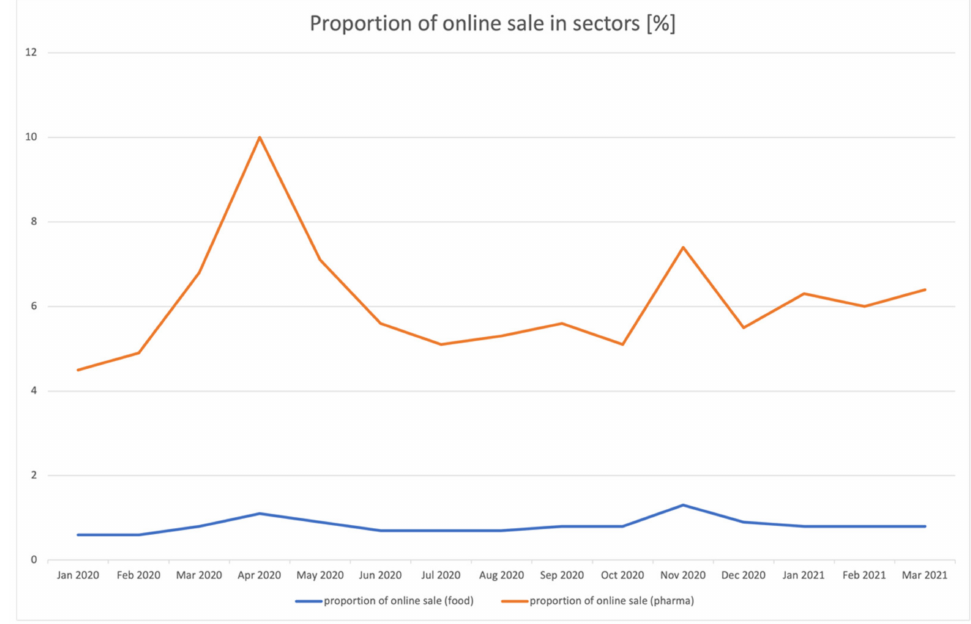
Figure 2. Share of online sale in the pharmaceutical and food sectors for January 2020–March